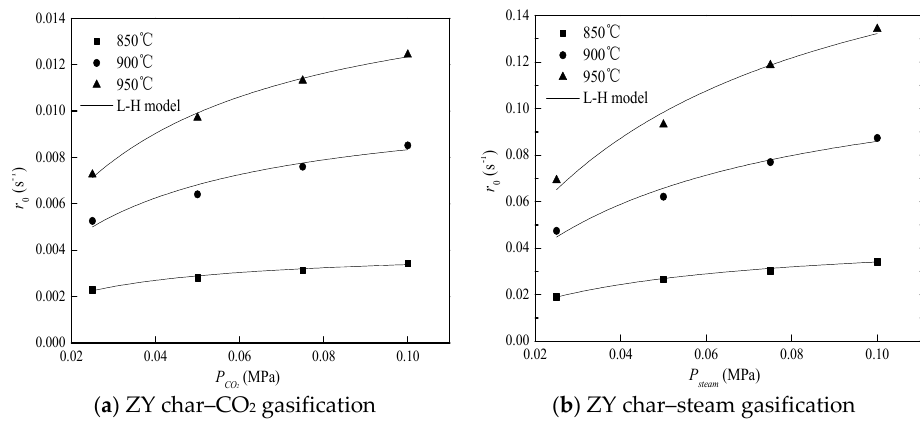
Figure 3. Effect of steam–CO 2 partial pressure on gasification rate.